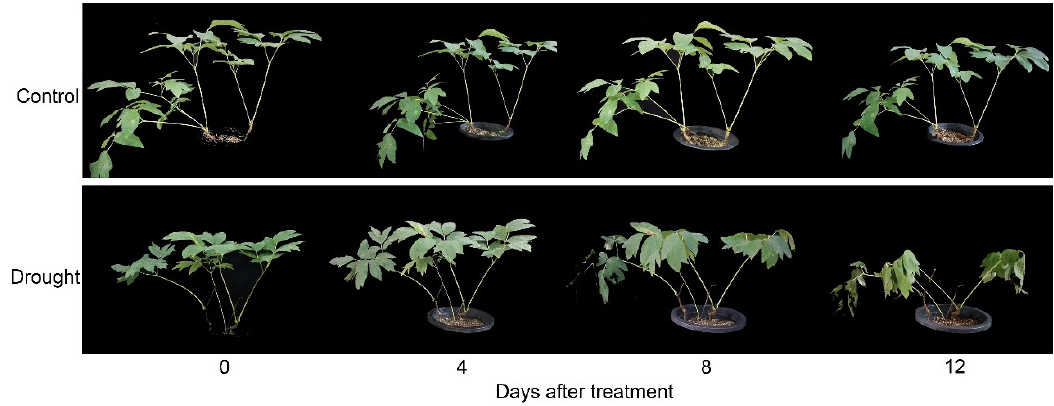
Figure 1. Phenotypic changes of drought-treated P. ostii and the control.